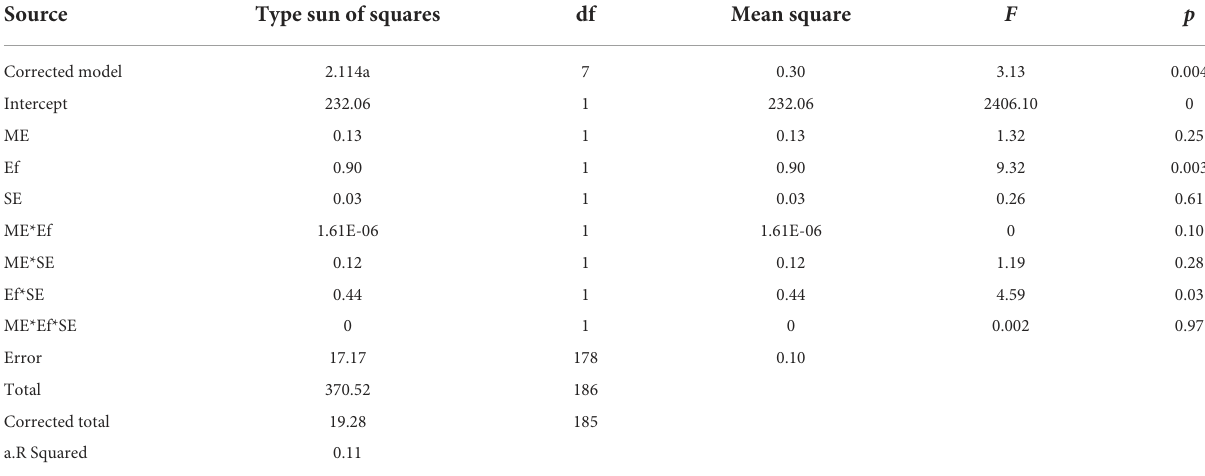
TABLE 3 The multivariate analysis of ME, Ef, and SE on the improvement of GPA.